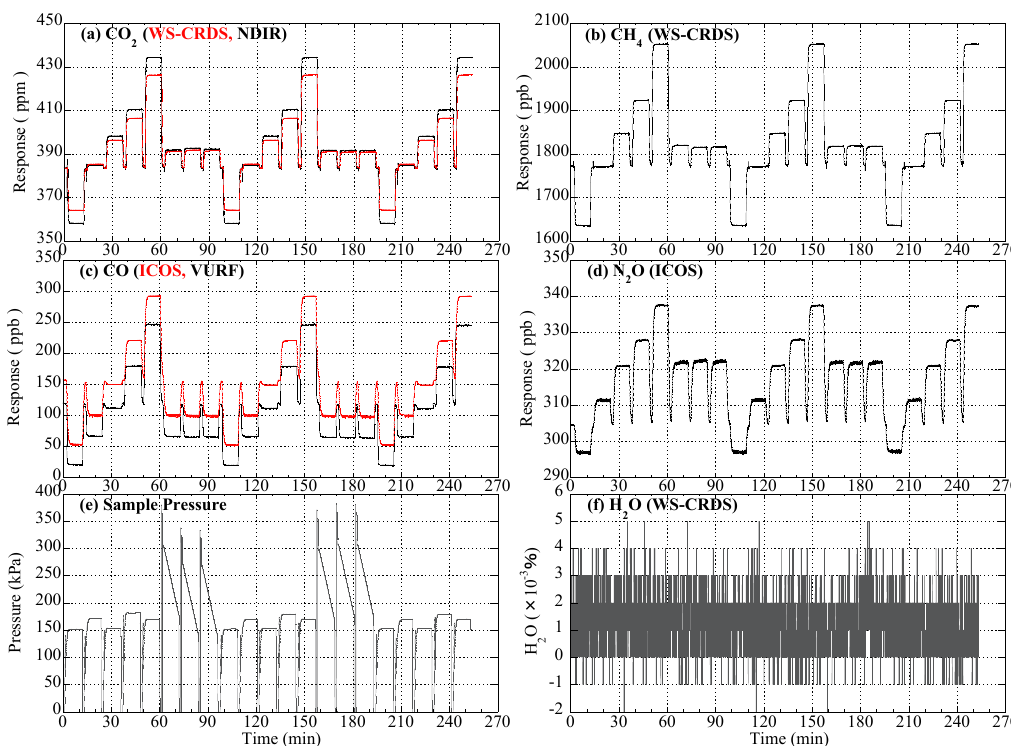
Fig. 3. An example of the response time series of CO 2 (a) for the NDIR and WS-CRDS analyzers, CH 4 (b) for the WS-CRDS analyzer, CO (c) for the VURF and ICOS analyzers, N 2 O (d) for the ICOS analyzers, sample pressure (e) for the pressure sensor PS-7, and H 2 O (f) for the WS-CRDS analyzer from the experimental analyses of 6 flask air samples together with 5 working standard gases. Details of the analytical sequence and procedure are described in the